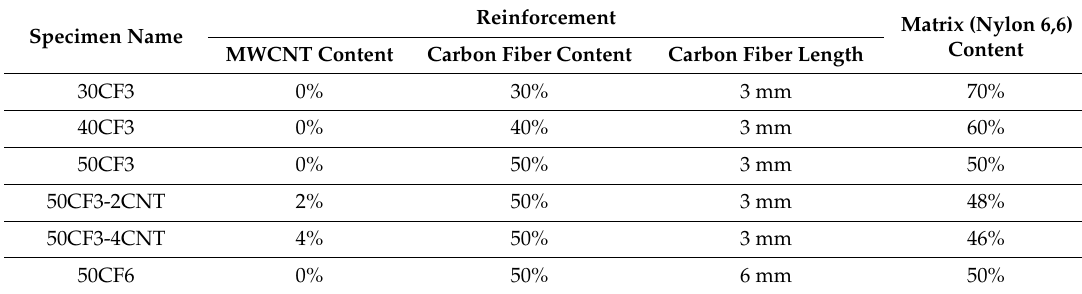
Table 1. Specimen composition of hybrid composites.